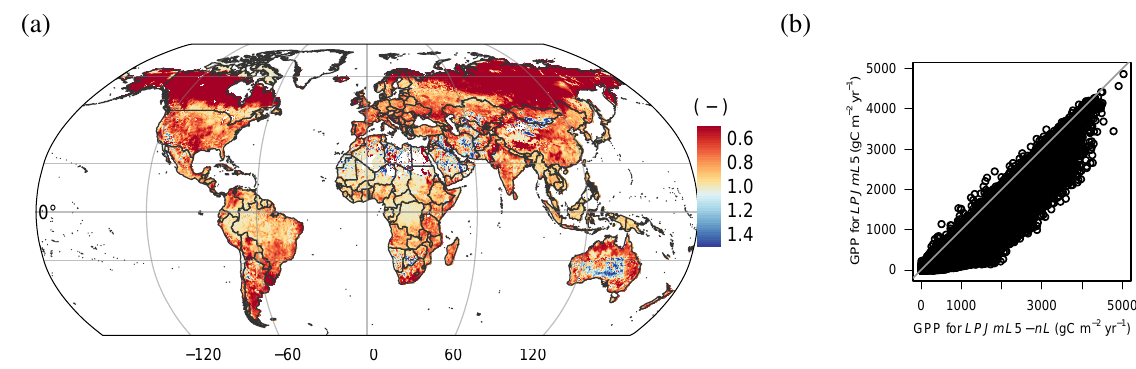
Figure 5. Ratio of GPP under actual N limitations ( LPJmL5 ) to unlimited N supply ( LPJmL5-nL ) (a) ; values less than 1 indicate higher GPP under unlimited N supply. The scatter plot (b) shows that GPP is increased through additional N supply mostly in low to moderately productive